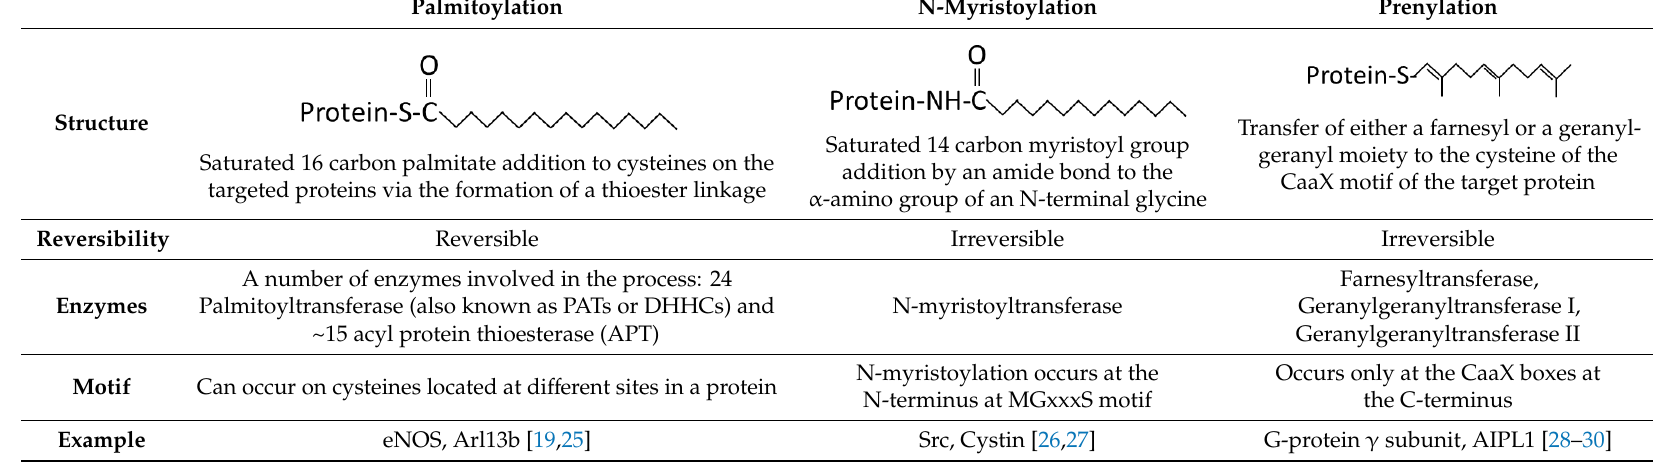
Table 1. Common lipid modifications at a glance.